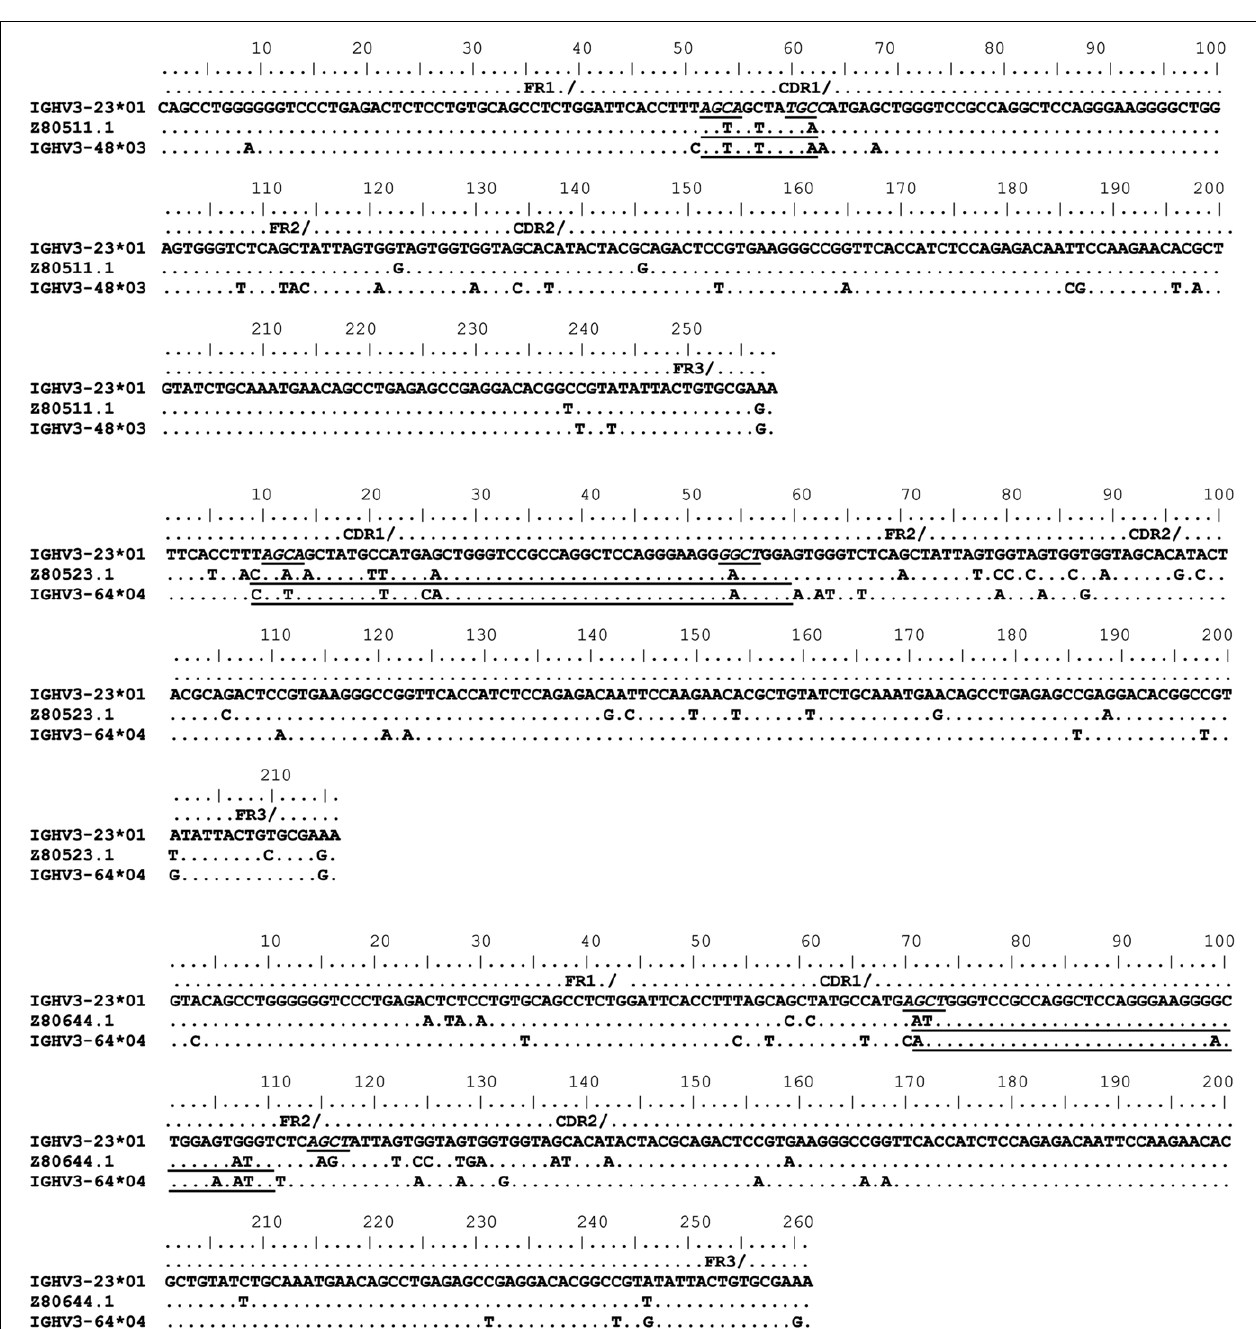
is the germline of rearranged IGHV3-23*01 gene sequences from healthy individuals (Z80511.1, Z80523.1, and Z80644.1). Potential donor germline IGHV3 family gene segments are shown below the rearranged IGHV3-23*01 sequences. GCV-like tract is underlined. Flanking SHM/AID hotspot motifs are underlined and